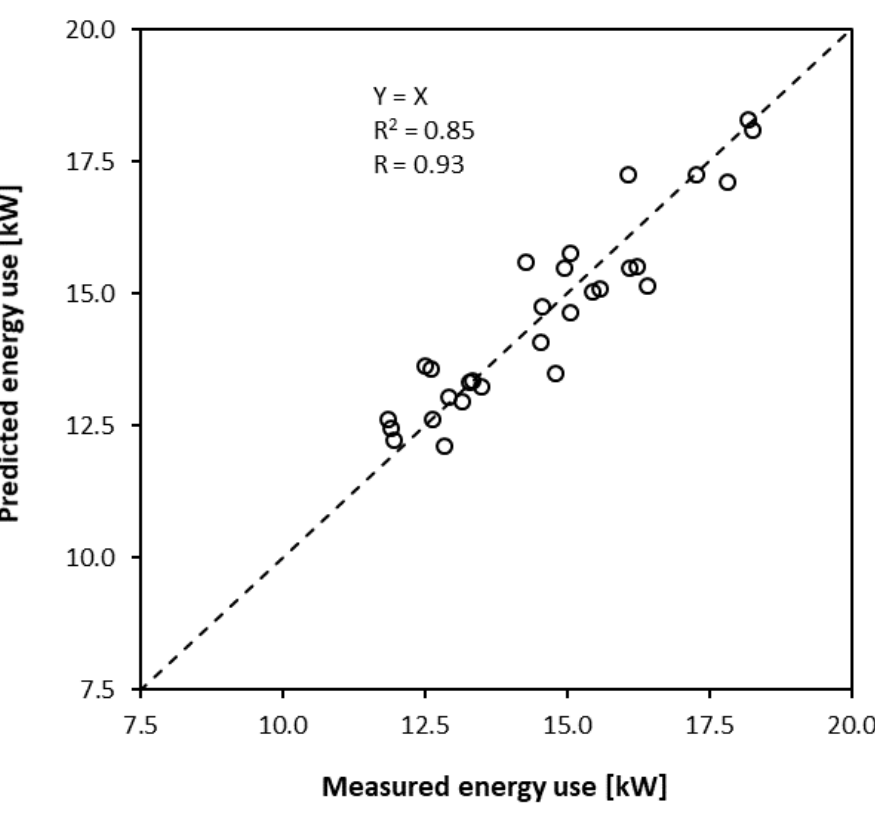
Figure 10. The predicted power consumption plotted against the measured power consumption. The Pearson correlation coefficient is given as the R-coefficient.